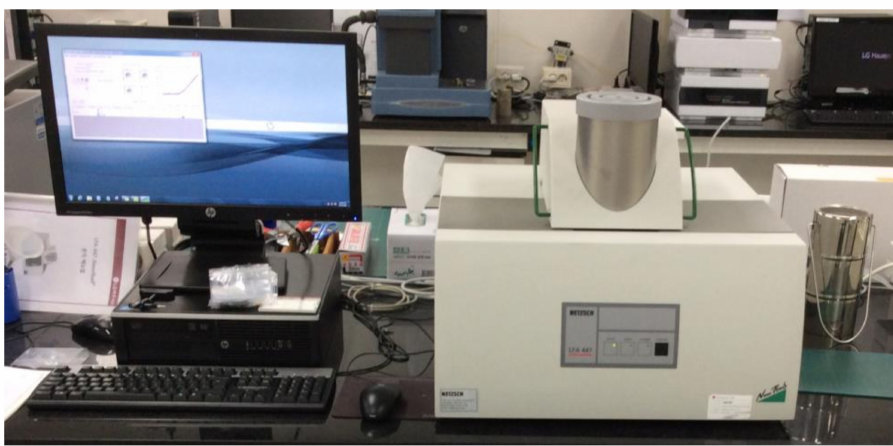
Figure 3. Apparatus used for the measurement